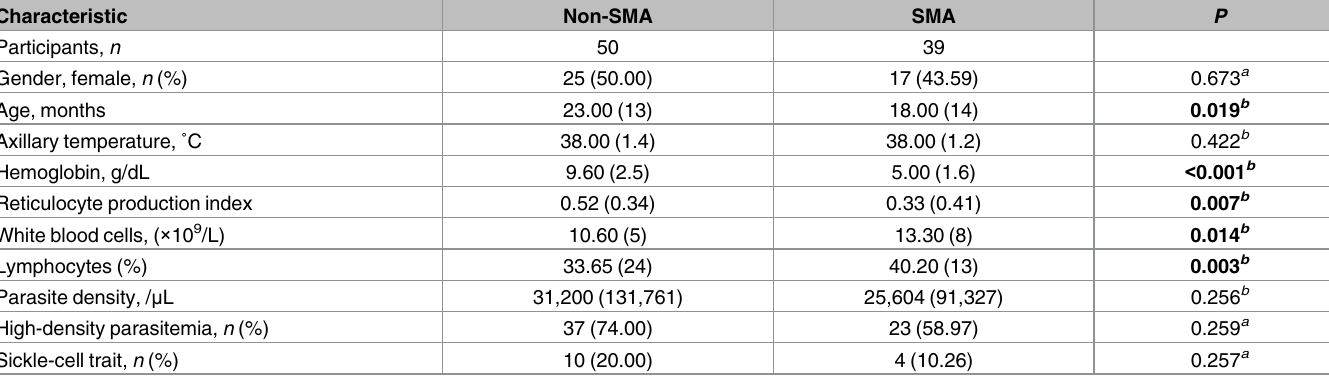
Table 1. Demographic, clinical and laboratory characteristics of study participants.